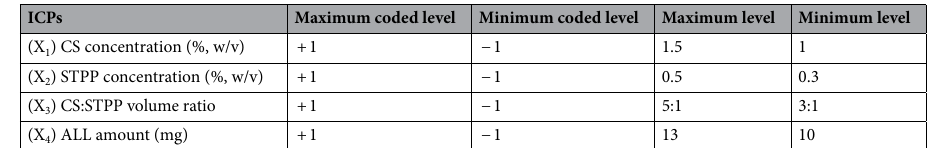
Table 1. ICPs and levels of a 2 4 full factorial design.